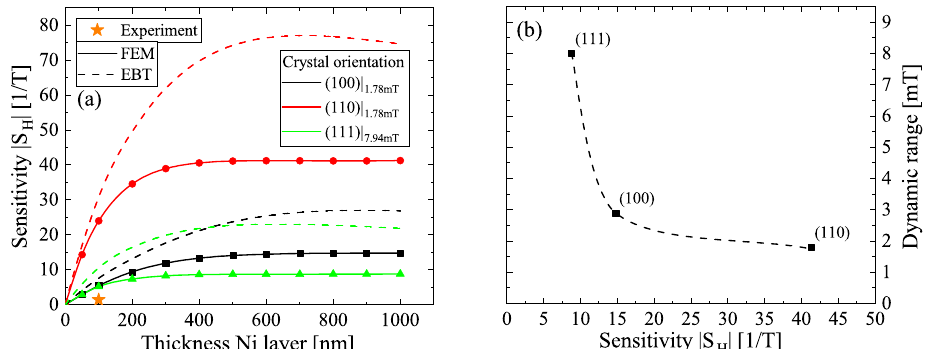
Figure 5. ( a ) Absolute values of the maximum sensitivities derived from Figure 4 (FEM) and from the Euler–Bernoulli theory (EBT) for the three principal axes and t Ni , sat at the given offsets of the magnetic flux. The experimentally achieved sensitivity is added for comparison. The value for zero thickness is extrapolated. ( b ) Extracted dynamic range in dependence of | S H | for the three orientations.